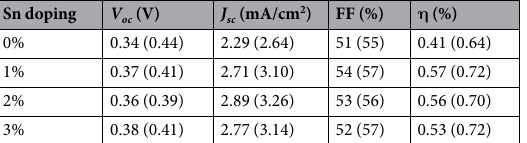
Table 1. Solar cell characteristics presented here are the statistical average of more than 40 solar cells of each kind out of 12 different and independent batches. Champion cell parameters are written in